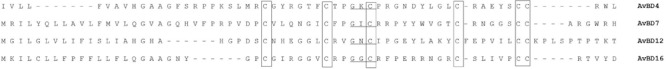
Deduced amino acid sequence alignment of four novel avian β-defensin (AvBDs) from geese. The six conserved cysteines (C) are framed. The GXC motif is underlined. Dashes indicate that no identical or conserved residues were observed.